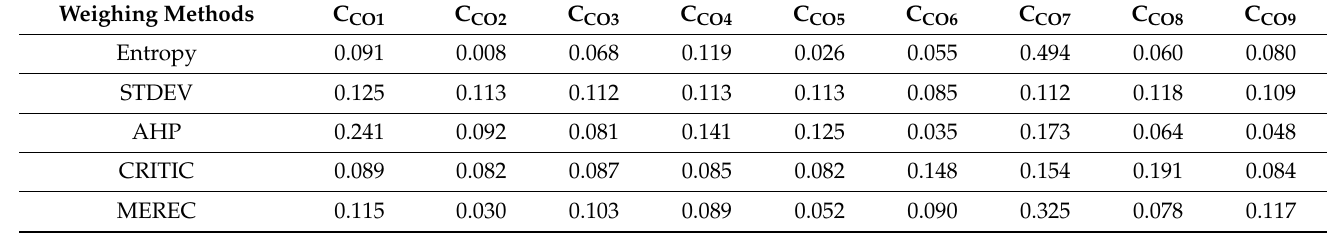
Table 8. Criteria weights derived by the different weighing methods.